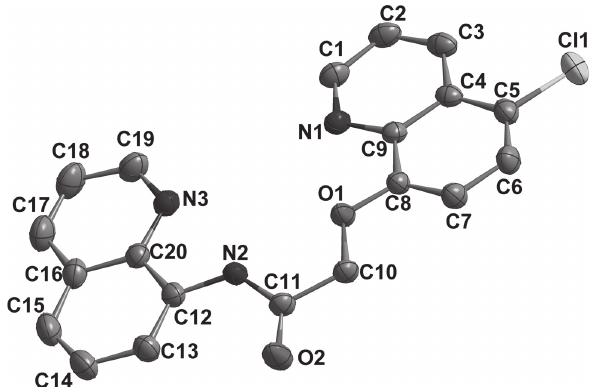
Table 2: Fractional atomic coordinates and isotropic or equivalent isotropic displacement parameters (Å 2